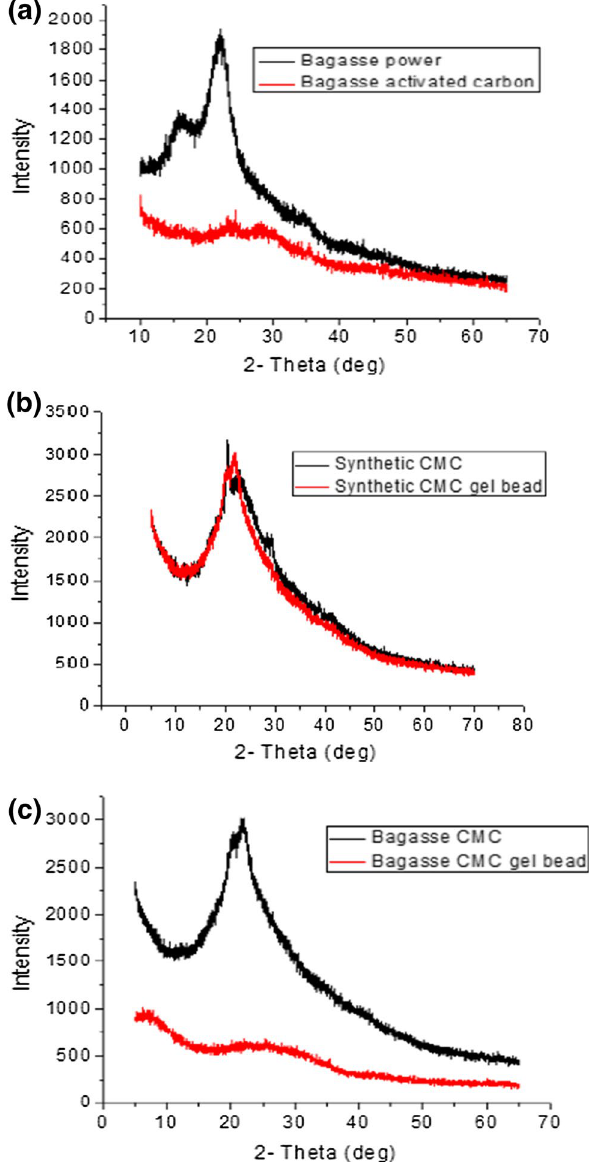
Fig. 6 a XRD spectra of bagasse powder and activated carbon, b XRD spectra of synthetic CMC and synthetic CMC bio-polymeric gel bead and c XRD spectra of bagasse CMC and bagasse CMC